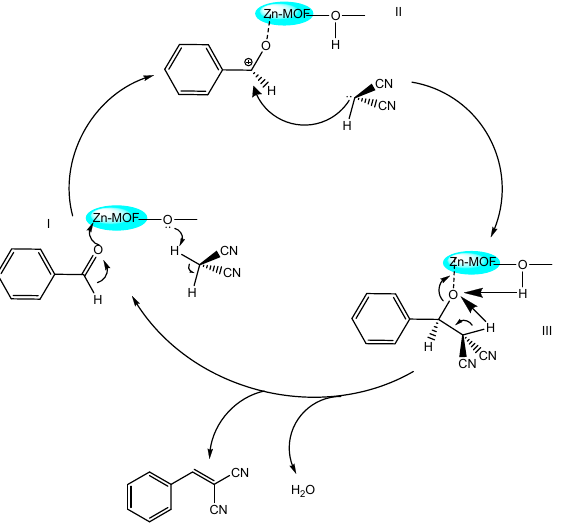
Figure 9. Plausible reaction mechanism for condensation reaction. [101].